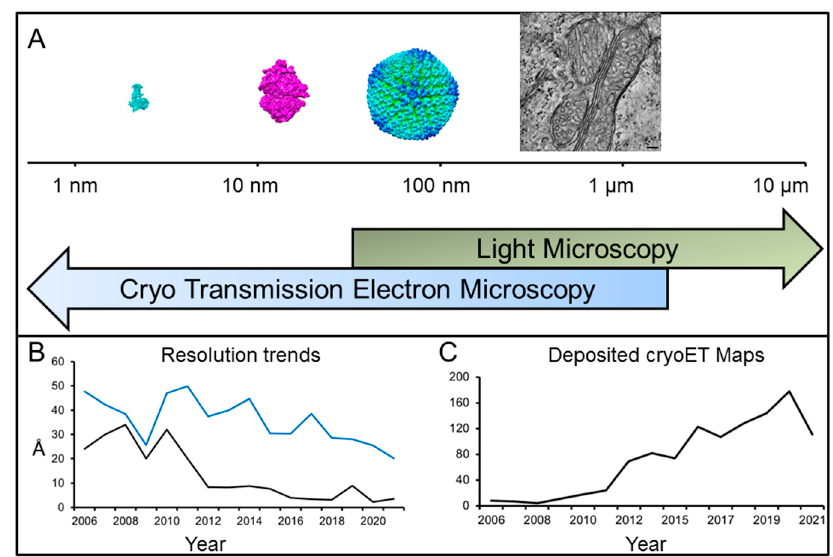
Figure 1. Cryo-electron microscopy is a multiscale technique with sub-nm resolution. ( A ) Electron microscopy covers a wide resolution scale. In cyan is the cryoEM structure of the α adrenergic receptor (cyan,EMDB-22357), the human ribosome is an example of a MDa molecular machine (magenta, EMDB-11796), adenoviruses (blue and green) are at the upper limit of single particle analysis (green/blue, EMDB-10768). The electron tomogram of mitochondria from the retina (EMDB-11125) is an example of an imaging regime where electron microscopy and light microscopy overlap. ( B ) Resolution range of maps solved with sub-tomogram averaging. In black is the trend for maps with the highest resolution and in blue, the average resolution. The impact of direct electron detectors around 2012 is clearly visible. ( C ) Trend of tomography maps deposited in the electron microscopy database.